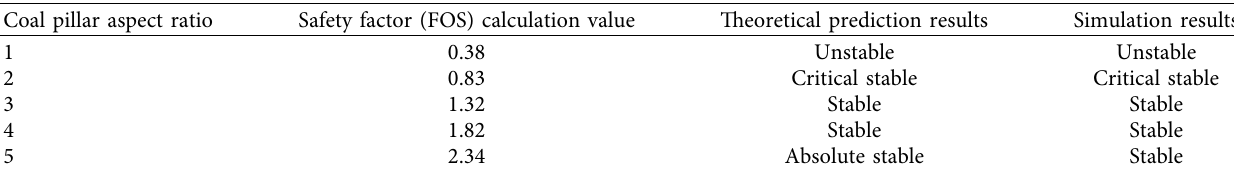
Table 4: Comparison between theoretical prediction and simulation results.